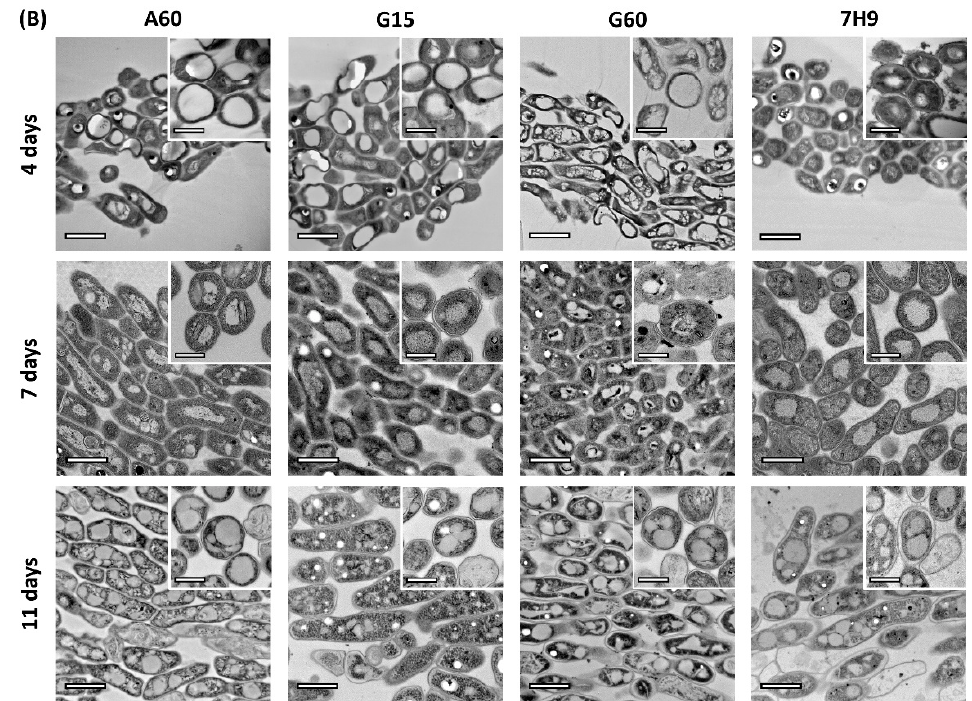
Figure 1. Development of M. brumae pellicles and associated lipids during pellicle development in different culture media. ( A ) Thin layer chromatography shows the lipid extract obtained from pellicles grown in each culture medium at 4 (initial), 7 (medium), and 11 (mature) days of development. Lipids were eluted in hexane:diethyl ether:glacial acetic acid (80:20:1, v / v / v ) and revealed with 10% molybdophosphoric acid in ethanol. Wax esters (WE) and acylglycerols (AG) were distinguished. ( B ) TEM representative micrographs exhibit the appearance of the pellicle stages at each development state. Scale bars correspond to 1 µm in pellicle general views and 300 nm in bacilli details. Sauton A60, G15, G60 media or Middlebrook 7H9 medium were used to culture mycobacteria. A60 is Sauton containing L-asparagine and 60 mL/L of glycerol (6% v / v ). Sauton G15 and G60 contain L-glutamate and 15 or 60 mL/L of glycerol (1.5% and 6% v / v ), respectively.